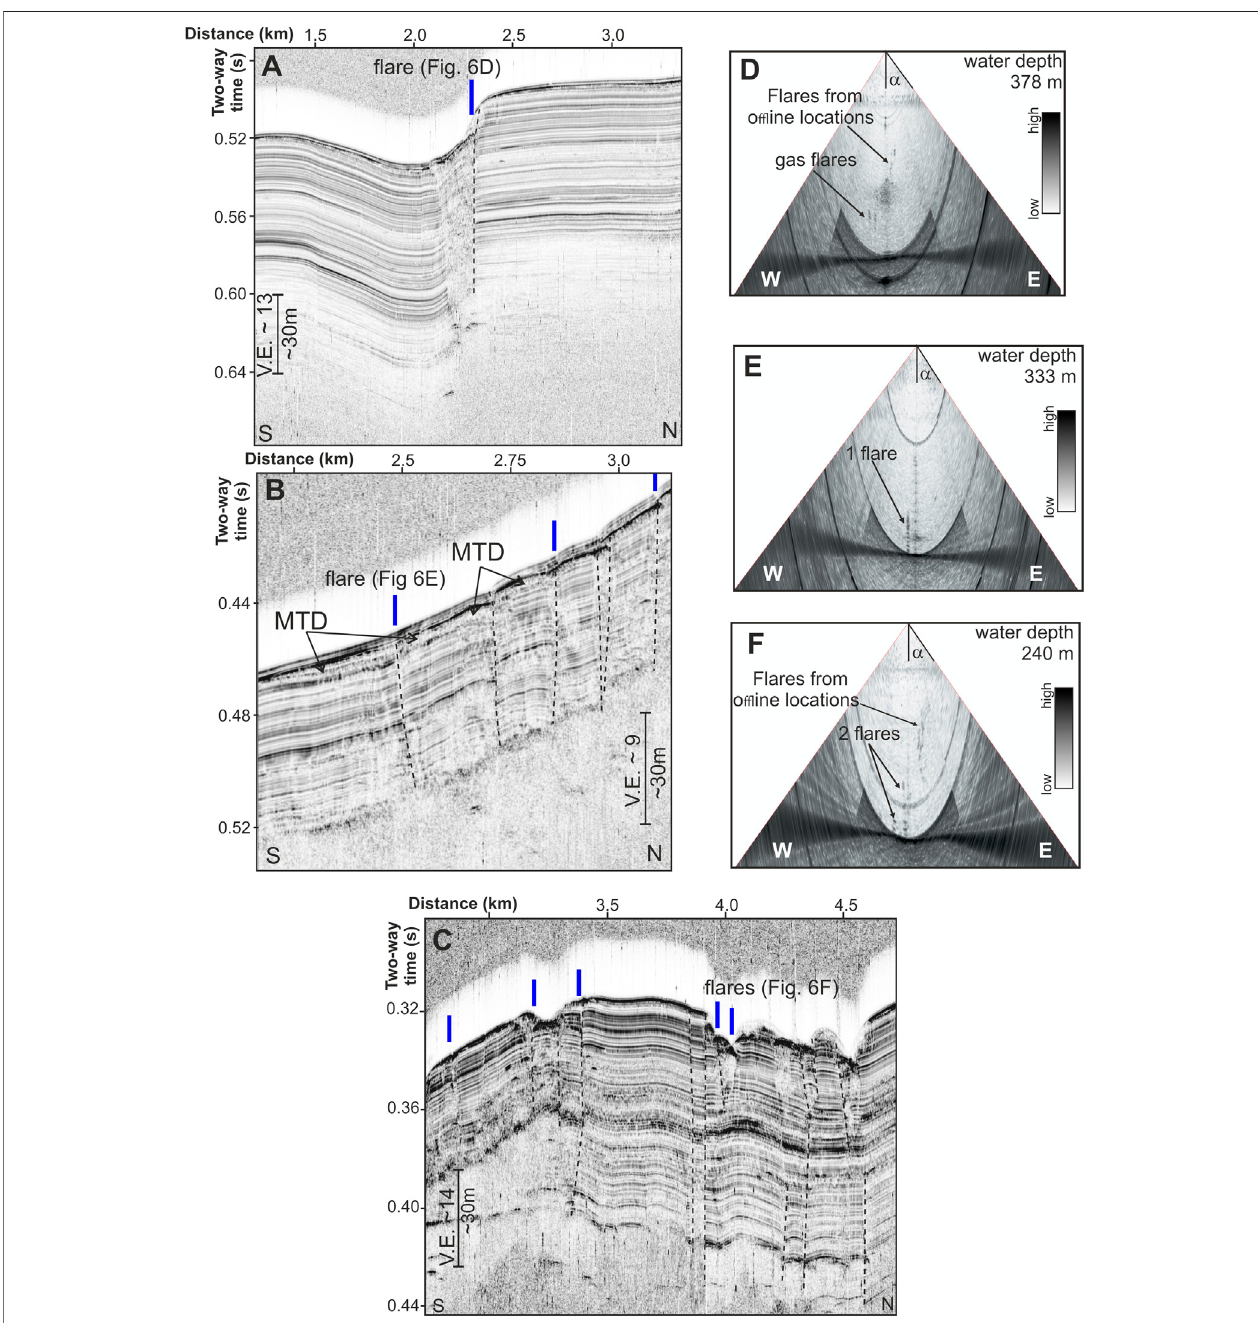
FIGURE 6 | Sub-bottom pro fi ler showing (A) ∼ 20 m vertical offset at E-W trending normal fault, (B) mass-transport deposit (MTD) sluffed off the canyon wall creating high sea fl oor backscatter although it is covered by 3 – 5 m thick sediment drape, and (C) fault-related erosional gullies (elongated depressions) on top of the N2 canyon plateau. Location of gas venting sites are shown as vertical blue lines. Selected faults are indicated by dashed black lines. (D – F) Examples of gas fl ares from the EM710 water column data. Beam-opening angle α is 60 ° .